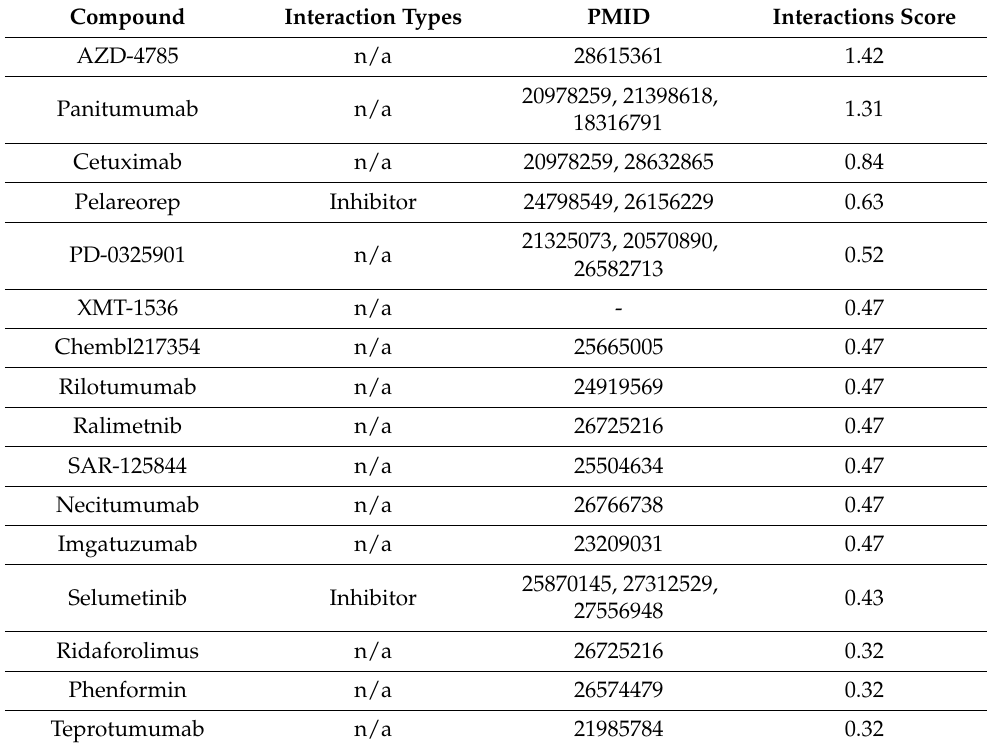
Table 5. Drug–gene interactions or potentially available drug categories with abnormal expression of KRAS. Compound Interaction Types PMID Interactions Score AZD-4785 n/a 28615361